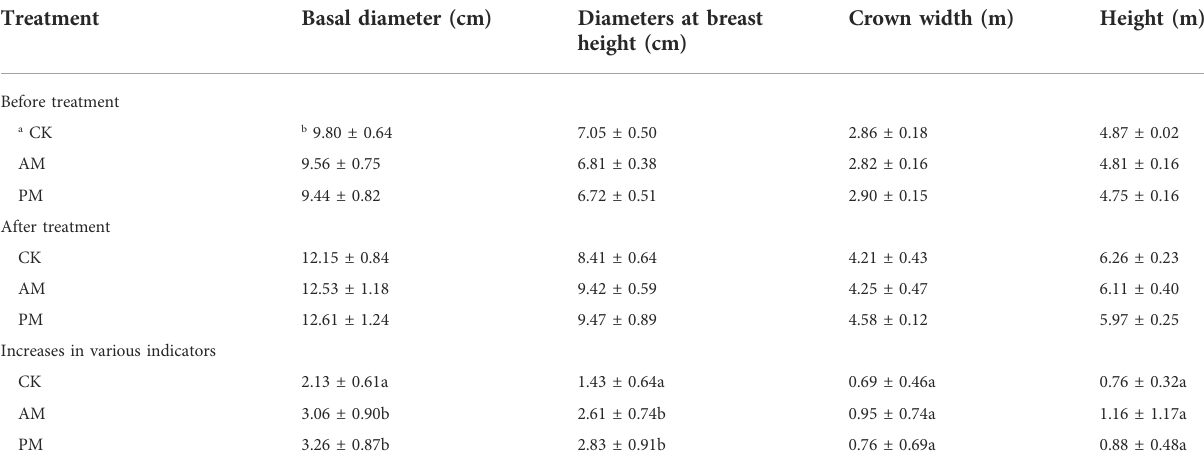
TABLE 3 Changes in growth indicators of H. chrysanthus .